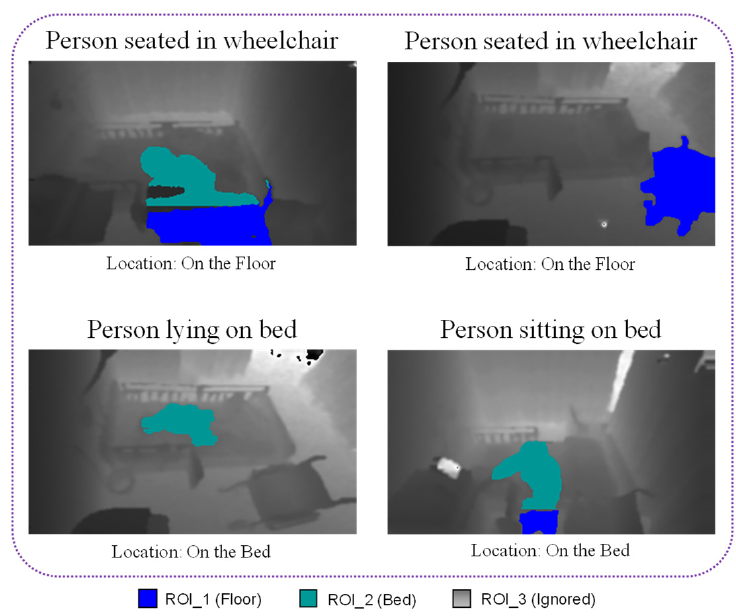
Figure 7. Person localization for different frames.